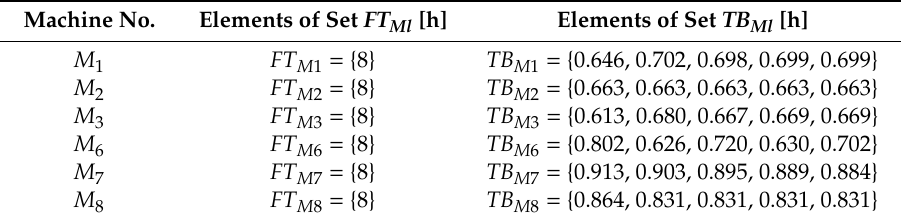
Table 5. The data implemented into the robust production